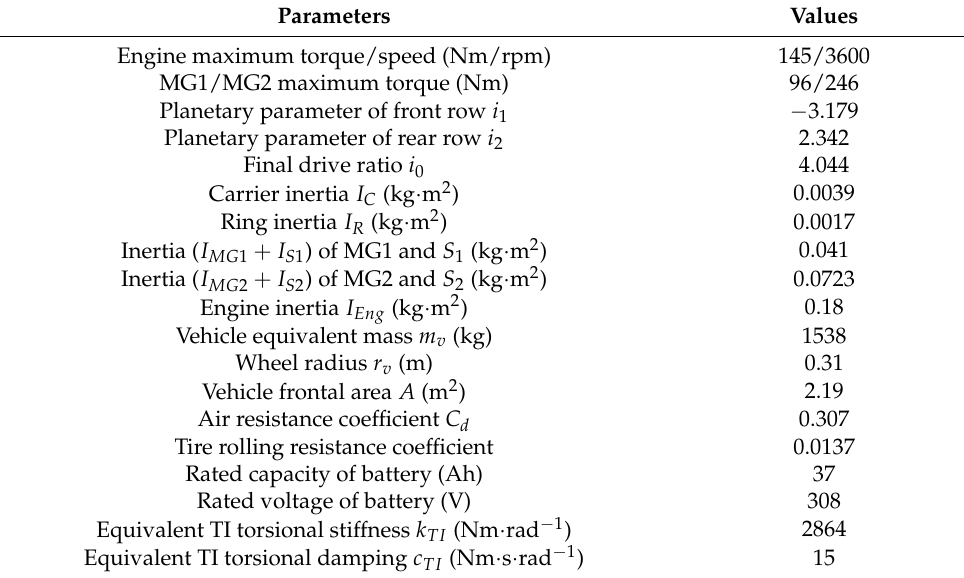
Table 1. Main PS-PHEV Parameters.